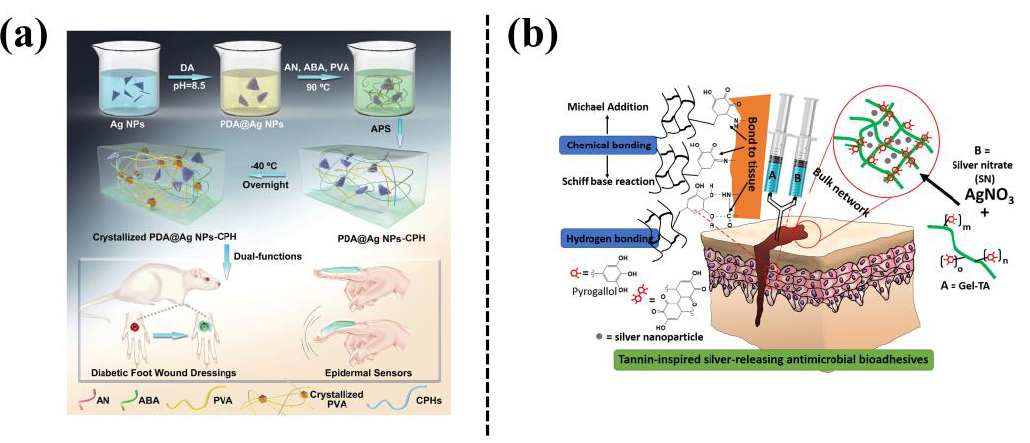
Figure 5. ( a ) Synthesis of a PDA@Ag NPs-CPH hydrogel and its applications as an epidermal sensor and diabetic-foot-wound dressing [61]. ( b ) Tannin-inspired antimicrobial bioadhesives crosslinked by silver nitrate (SN) [62].